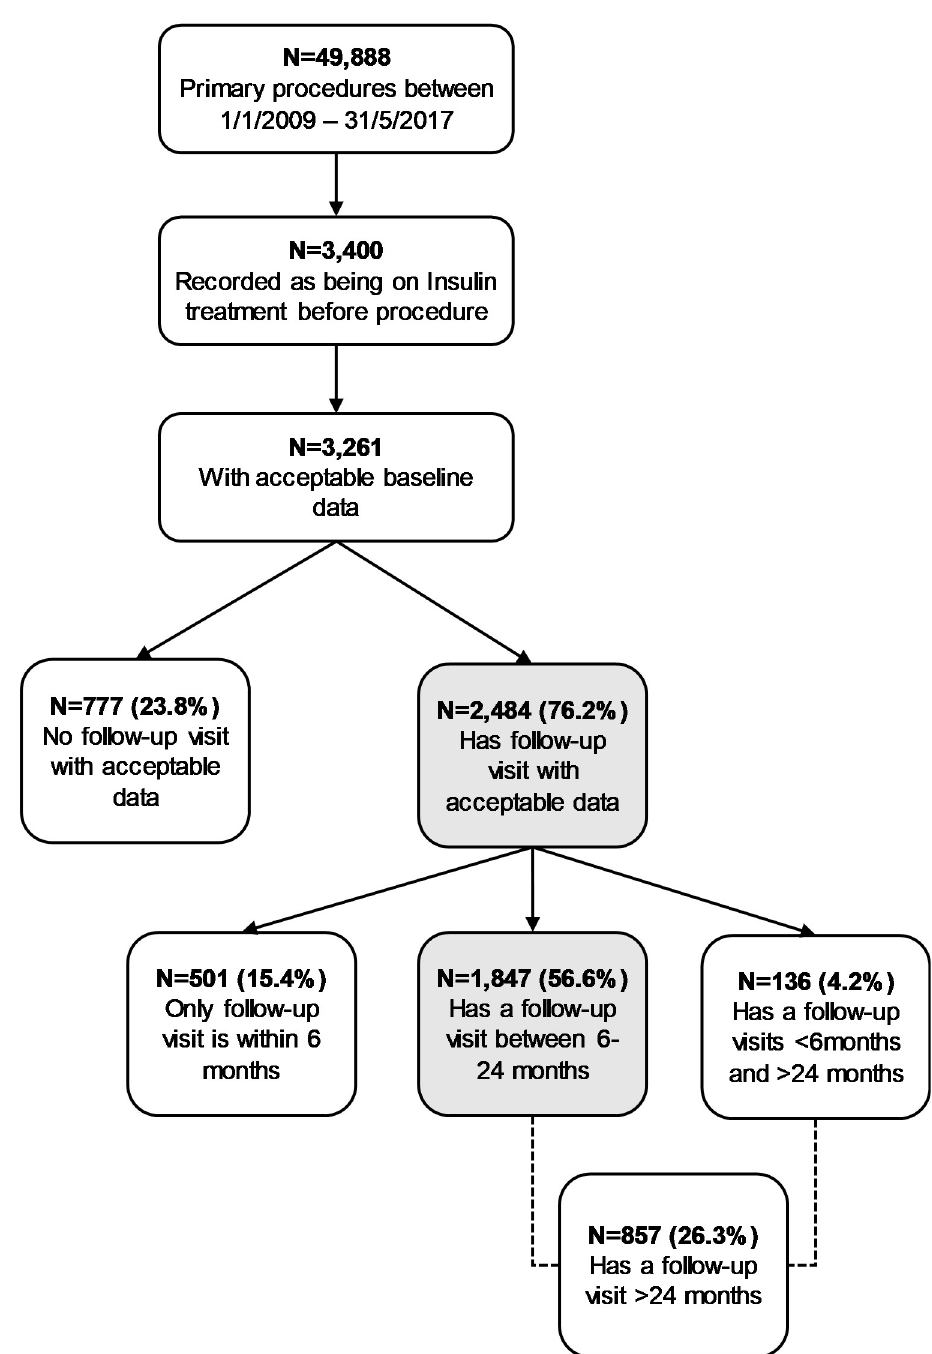
Fig 1. Flowchart to illustrate selection of surgical patients from NBSR database for the clinical study. NBSR, National Bariatric Surgical Registry.